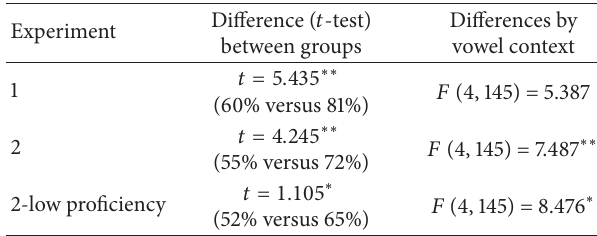
Table 3: Results by experiment for general discrimination rate for thickandthinboundarygroupparticipants,withdifferencebetween group and difference by vowel within